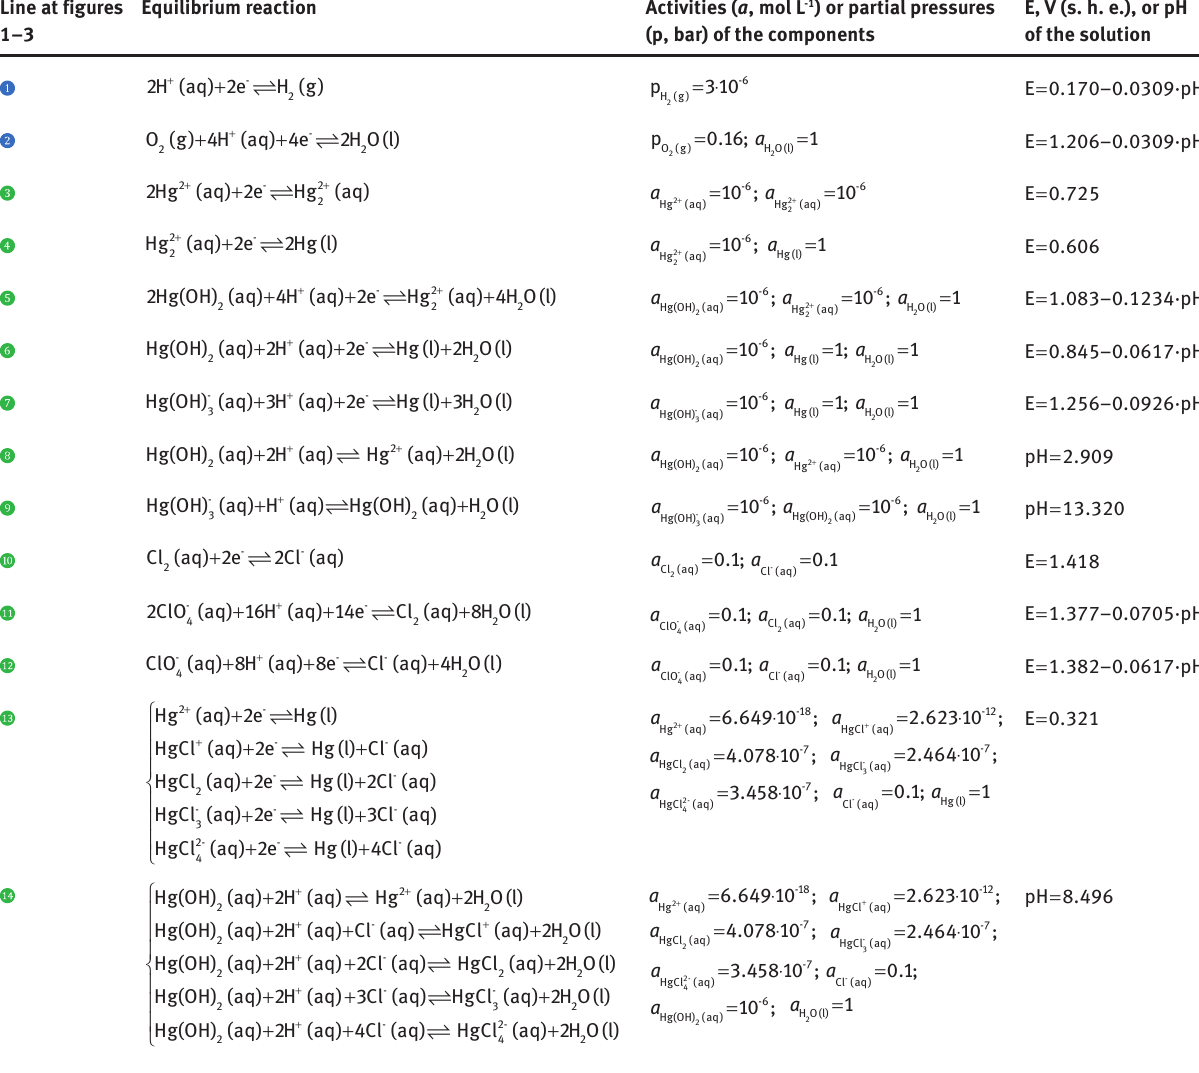
Table 2: The thermodynamic characteristics of basic chemical and electrochemical equilibria in 2 systems at 310.75 K and 1